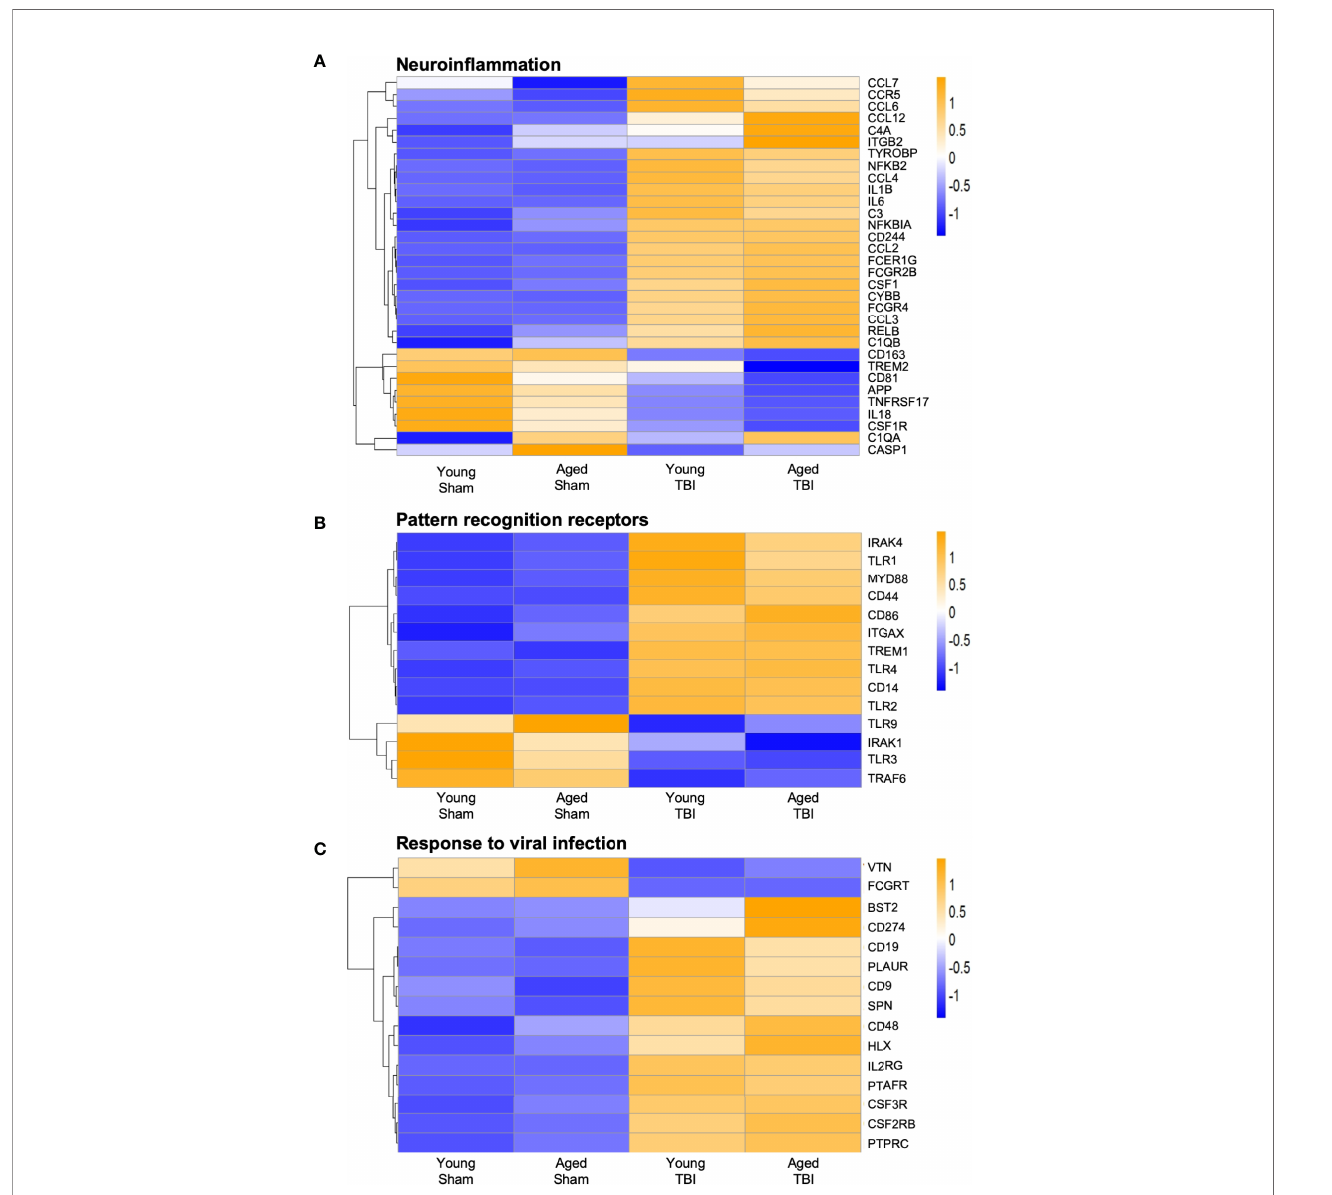
FIGURE 4 | Expression of selected genes related to neuroin fl ammation, pattern recognition receptor, and response to viral infection. Selected transcripts were grouped by known or suspected functions related to neuroin fl ammation (A) , pattern recognition receptors (B) and viral infection (C) . Blue (cool colors) were used to graph low expression levels and orange (warmer colors) depict higher expression levels. For A-C, the heat map color scale re fl ects normalized log-transformed raw counts scaled to z-scores, where -1=darker blue=decreased expression and 1=darker yellow=increased expression. For most but not all transcripts, TBI increases expression. For some transcripts, TBI in aged mice shows the highest level of expression, but this age effect was not statistically signi fi cant for any transcript in the TBI only